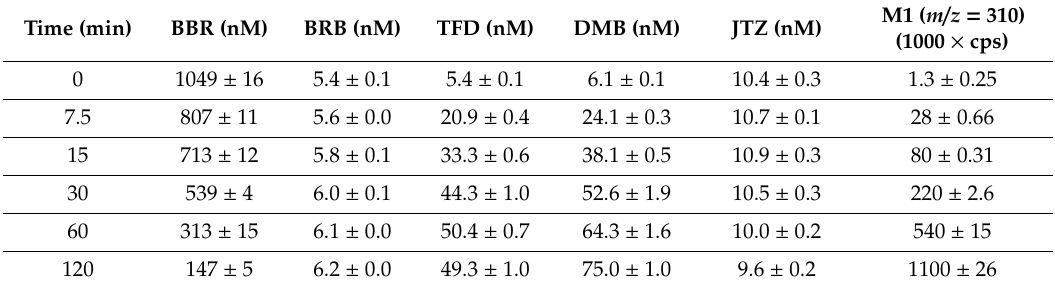
Table 1. Elimination of BBR and formation of its metabolites in pooled HLM.